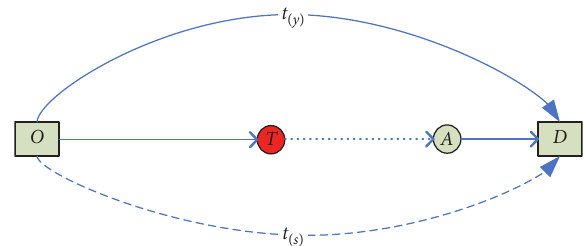
Figure 1: Diagram of the network of traffic emergencies en- countered during vehicle